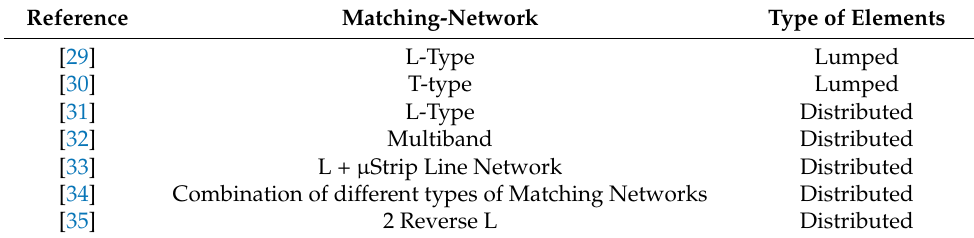
Table 2. Different types of Impedance Matching Networks.